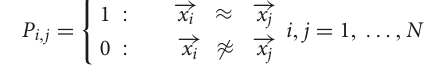
Figure 4A . An asterisk is placed at each time where the real value of coactivity exceeds the variable threshold. With this procedure, significant peaks of coactivation ( V P ) are determined from the subrasters (set of V A vectors). Different thresholds can be used with little change in the